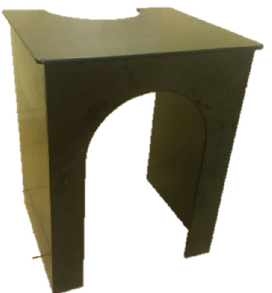
Figure 1. Wooden desktop workstation.